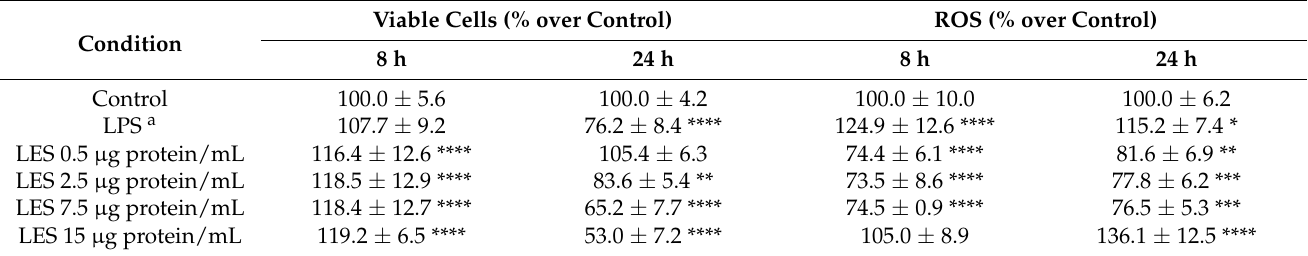
Significant differences compared to control (* p < 0.05; ** p < 0.01; *** p < 0.001; **** p < 0.0001). a LPS was used at concentrations of 10 ng/mL and 100 ng/mL in the cell viability and reactive oxygen species (ROS)